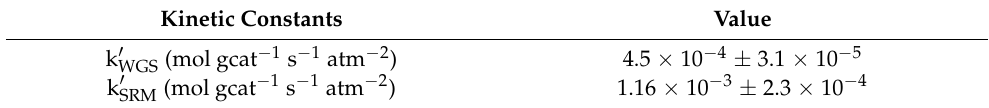
Table 7. Estimated kinetic constants at 600 ◦ C. Kinetic